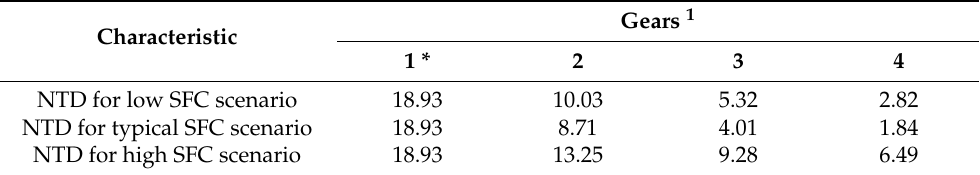
Table 6 for each SFC scenario. Under this transmission and gear shifting within the most energy-efficient speed range of the motor, the number of batteries required, acceleration capacity, CO 2 net emissions, autonomy, and TCO were determined and are specified in Table 7. Table 6. Geometrical gearbox ratios for CircuitoTec and an autonomy of 50 km. Characteristic